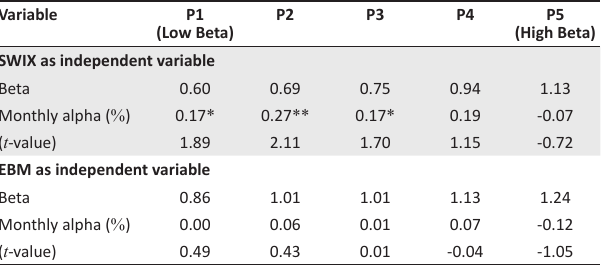
TABLE 2: Beta sorted quintile portfolio capital asset pricing model style regressions.